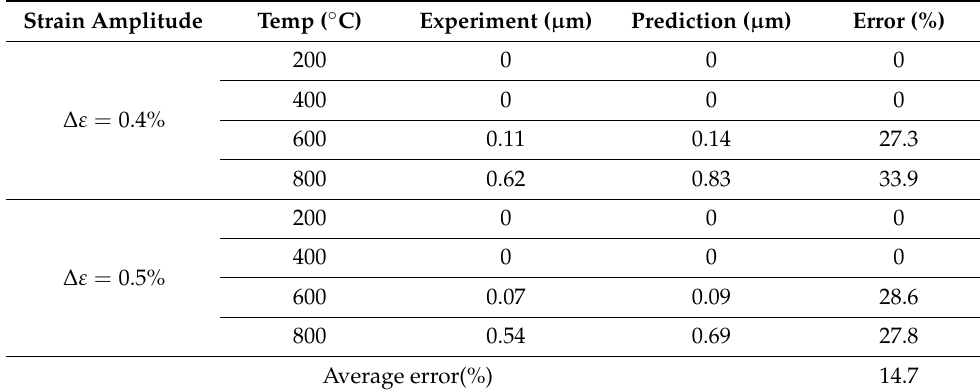
Table 3. Results of average thickness of oxide layer obtained from experiments and predictions. Strain